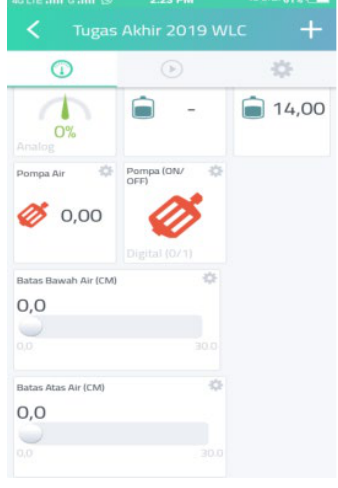
Figure 8. Display Design on Cayenne